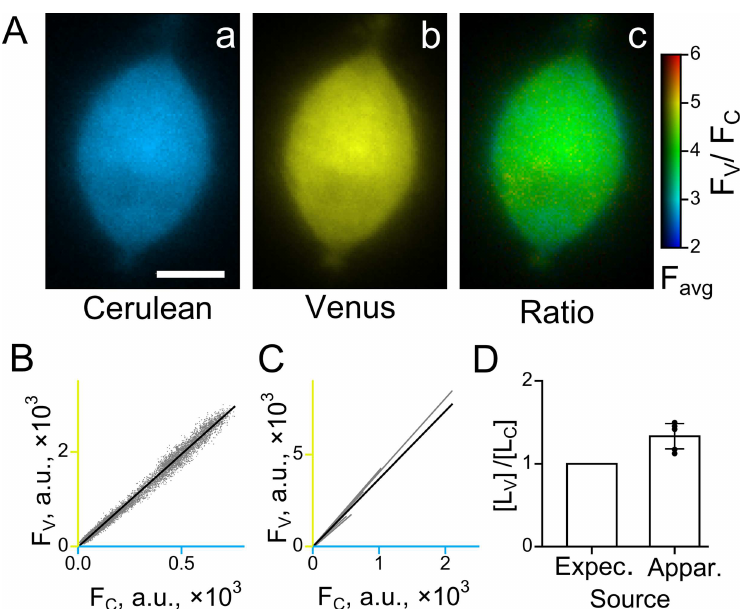
Fig 2. Estimation of approach accuracy using a tandem of Cerulean and Venus. (A) Images of representative PC12 cell expressing the tandem: Cerulean fluorescence (a), Venus fluorescence (b), and a ratio image of Venus to Cerulean fluorescence (c). A color and intensity of each pixel in (c) represent the ratio of Venus/Cerulean fluorescence and averaged intensity of respective pixels in the images (a) and (b) (F ,respectively. A scale bar in (a) is avr = (F C + F V )/2) 5 μ m. (B) A linear regression of correlation plot between Cerulean and Venus fluorescence intensities for each pixel within the PC12 cell image shown in (A). A strong linear correlation between the intensities (slope = 3.922 ± 0.004, intercept = 11.1 ± 0.01, R 2 = 0.99; the slope is significantly different from zero at the 0.05 level) demonstrates co- localization of fluorescent protein labels. ( C ) Linear regressions of correlation plots similar to one shown in (B) for five PC12 cells. Cells having different levels of tandem expression were chosen for this plot in order to demonstrate that the ratio of fluorescence intensities remains unchanged in the wide range of tandem expression levels. (D) Expected (Expec.) and apparent (Appar.) ratios of Venus to Cerulean concentrations in the tandem ([ L ]/[ L ]). The histogram V C demonstrates that the apparent ratio of Venus to Cerulean concentrations estimated based on the ratio factor (1.33 ± 0.06, mean ± S.E.M., n = 5) is close to the expected ratio, which is equal to 1. It indicates that an error associated with inaccurate determination of spectral properties of labels and equipment is about 30%.